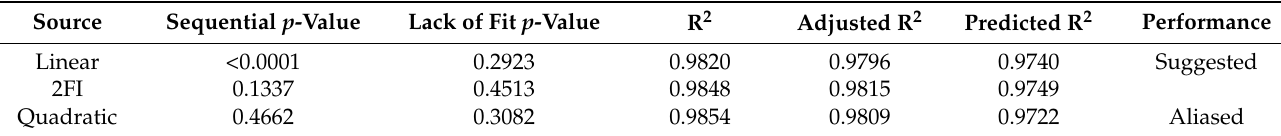
Table 8. Fit summary of the models.